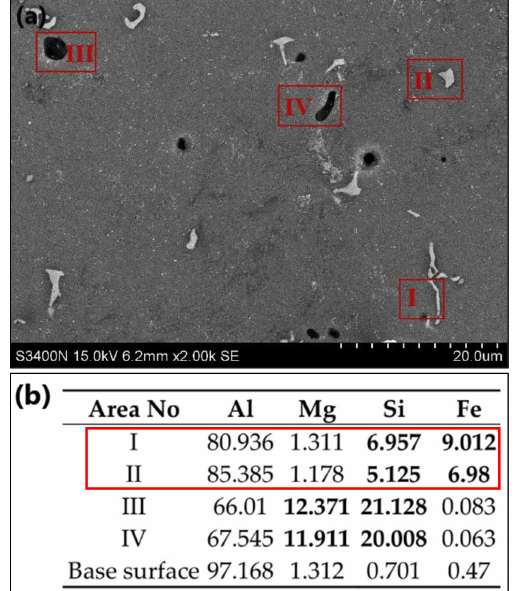
Figure 1. Chemical composition of AlFeSi in Al6061 from the previous study [15]: ( a ) SEM of the Al6061 samples; ( b ) EDX results of the Al6061 samples (Atomic %).